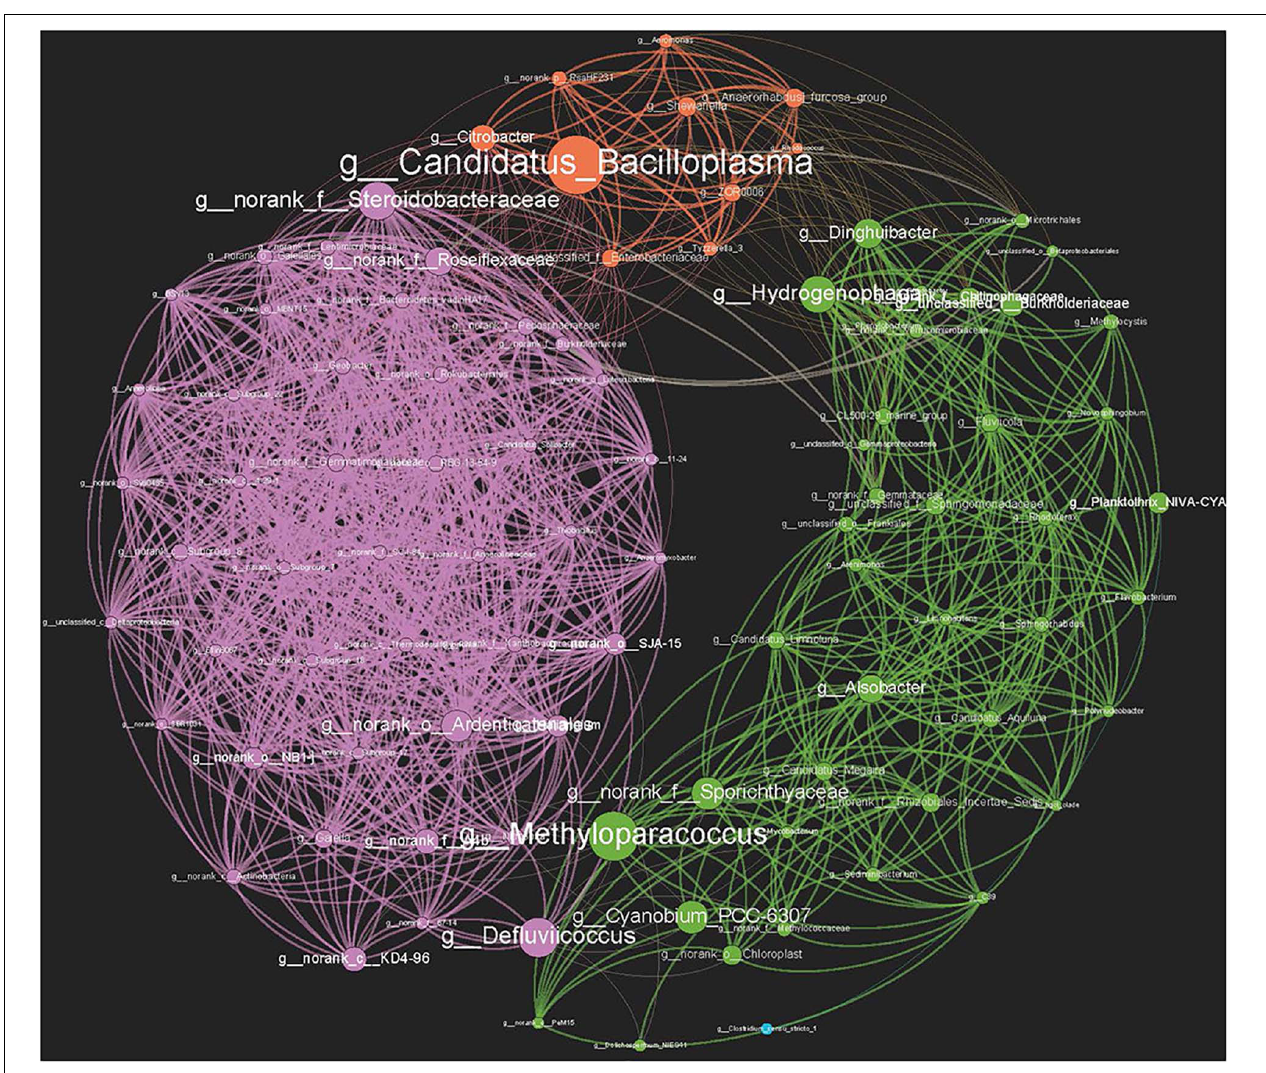
FIGURE 6 | Co-correlation network of bacterial genera based on Spearman correlation. High-confidence interactions with Spearman correlation ρ ≥ 0.75 were reserved. Three main modules, which correspond to the dominant genera in sediment, water, and crayfish intestine, respectively, were generated with a 0.409 modularity index. All networks are displayed as nodes (genera) and edges (significant interactions among genera nodes). The same node colors represent genera belonging to the same module. Purple: sediment module; green: water module: orange: crayfish intestine module. Node sizes indicate the betweenness centrality of the genera in the data